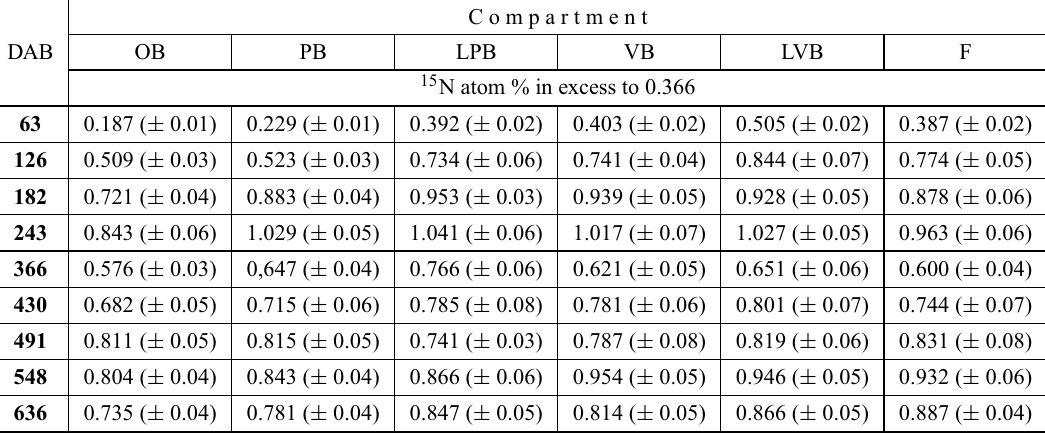
Means and standard errors (s m ) of l5 N enrichment as a function of time (DAB = days after beginning, starting Sept 1, 2003) for the different aerial compartments of the coffee plant, measured by mass